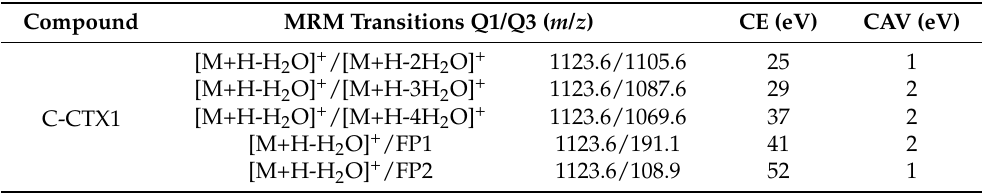
Table 1. MRM ion transitions monitored by LC-MS/MS for C-CTX1. FP : Finger Prints (Specific fragments selected as product ions, where FP1 corresponds to m / z 191.1 and FP2 corresponds to m / z